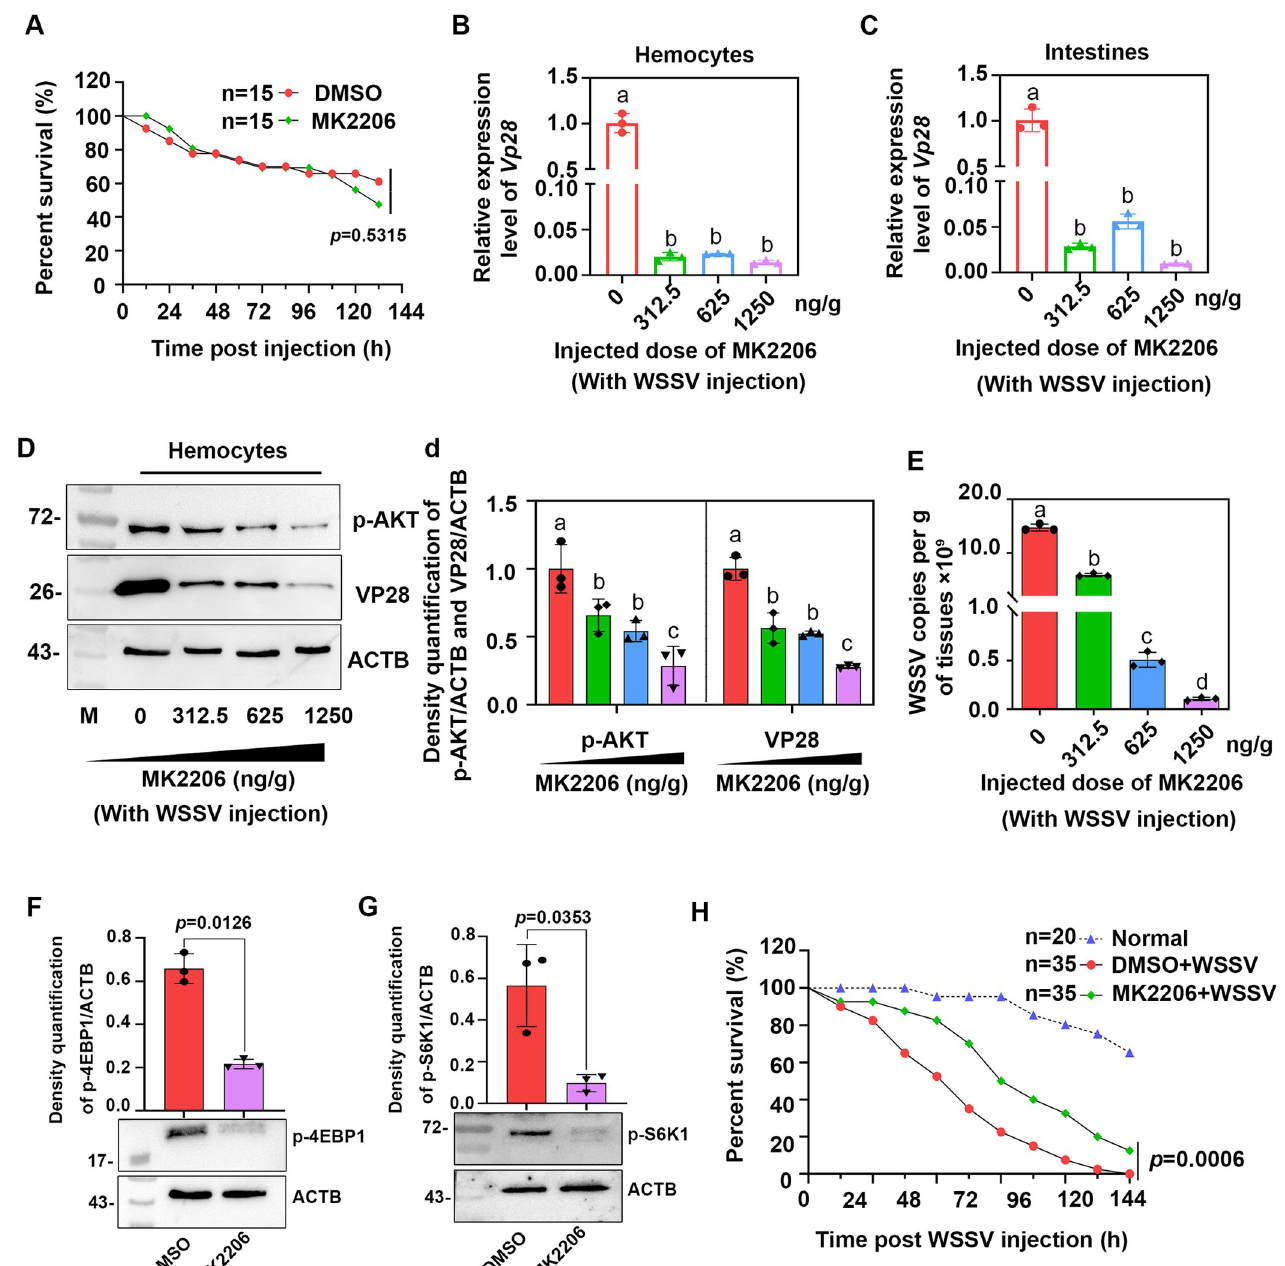
Fig 4. WSSV replication, 4EBP1 and S6K1 phosphorylation were inhibited by the AKT inhibitor, MK2206. ( A ) The toxicity of MK2206 on shrimp viability was detected following an injection with MK2206 (1250 ng/g body weight). The survival rate of each group was calculated, and the survival curves were presented as Kaplan-Meier plots. Differences between the two groups were statistically analyzed using a log-rank test in GraphPad Prism 8.0. ( B and C ) The level of Vp28 expression in the hemocytes (B) and intestine (C) of MK2206-injected shrimp following WSSV infection was analyzed by qPCR at 36 hpi. ( D ) The level of VP28 expression and AKT phosphorylation in the hemocytes of MK2206-injected shrimp challenged with WSSV and analyzed by Western blot. ACTB ( β -actin) was used as a loading control; ( d ) Statistical analysis of panel D based on three independent experiments. The subpanels of p-AKT and ACTB were from different gels with same amount of loading samples. ( E ) WSSV copy numbers in the intestines of MK2206-injected shrimp challenged with WSSV analyzed by qPCR at 36 hpi. ( F ) The level of 4EBP1 phosphorylation in the DMSO- or MK2206-injection groups (1250 ng/g body weight) analyzed by Western blot at 36 hpi. The upper panel represents the statistical analysis of three independent experiments of the lower panel. ( G ) The level of S6K1 phosphorylation in the DMSO- or MK2206-injection groups (1250 ng/g body weight) analyzed by Western blot at 36 hpi. The upper panel represents the statistical analysis of three independent experiments of the western blot. The subpanels of p-S6K1 and ACTB were from different gels with same amount of loading samples. ( H ) The survival rate of shrimp following an injection with MK2206 and WSSV compared with the control group. The survival rate of each group was calculated,